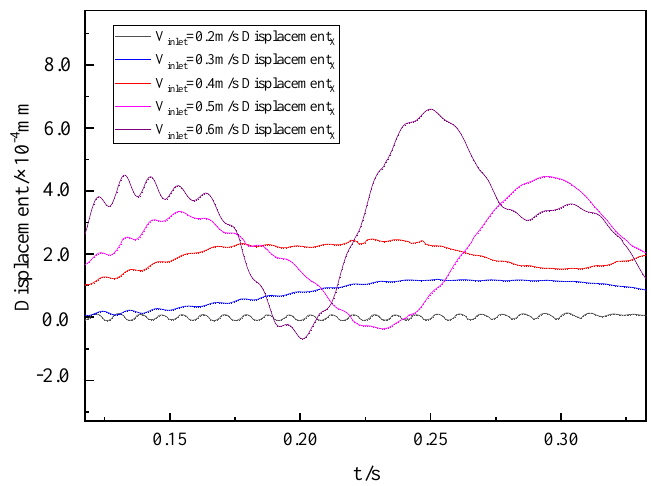
Figure 11. Vibration displacement response of C3: ( a ) axial; ( b ) radial.